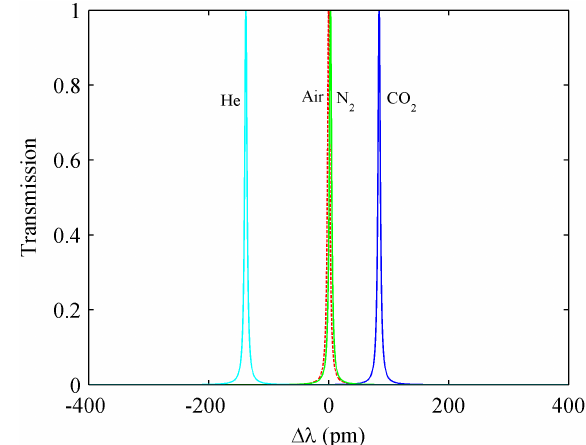
Figure 5. Transmission and spectral position of the cavity mode for different gases with air as the reference medium. The mode has a very narrow bandwidth of 4.3pm.